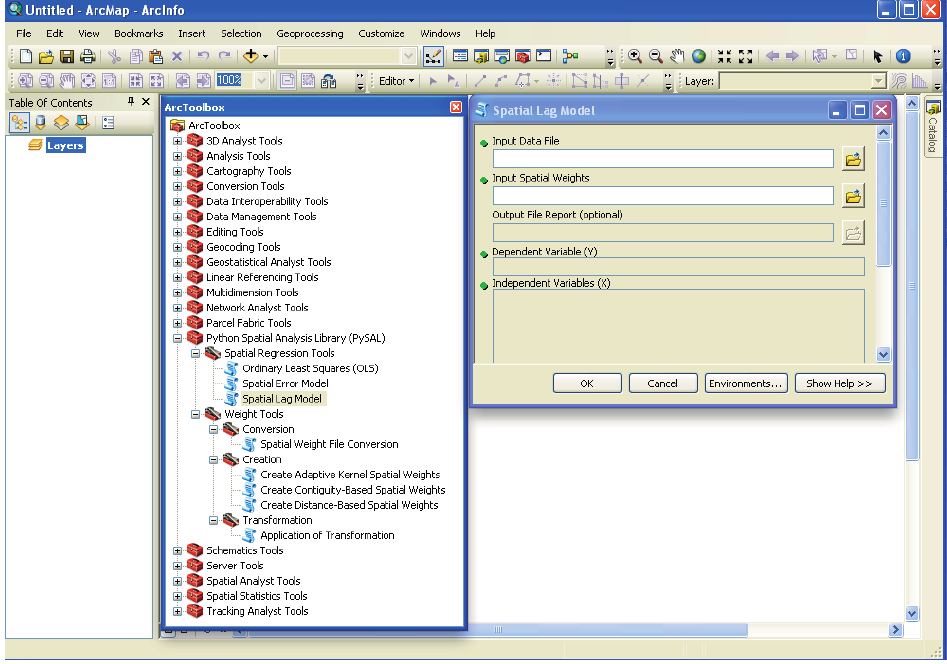
Figure 3. PySAL delivered as an ArcGIS Toolbox.